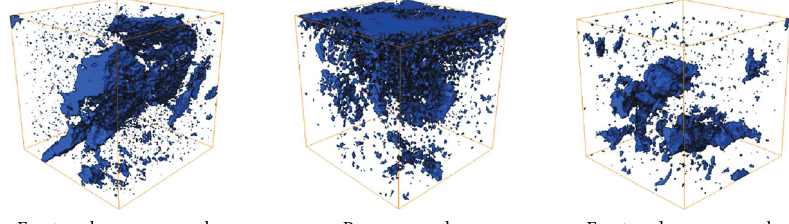
Figure 2: The pore phase of 3D digital rock.